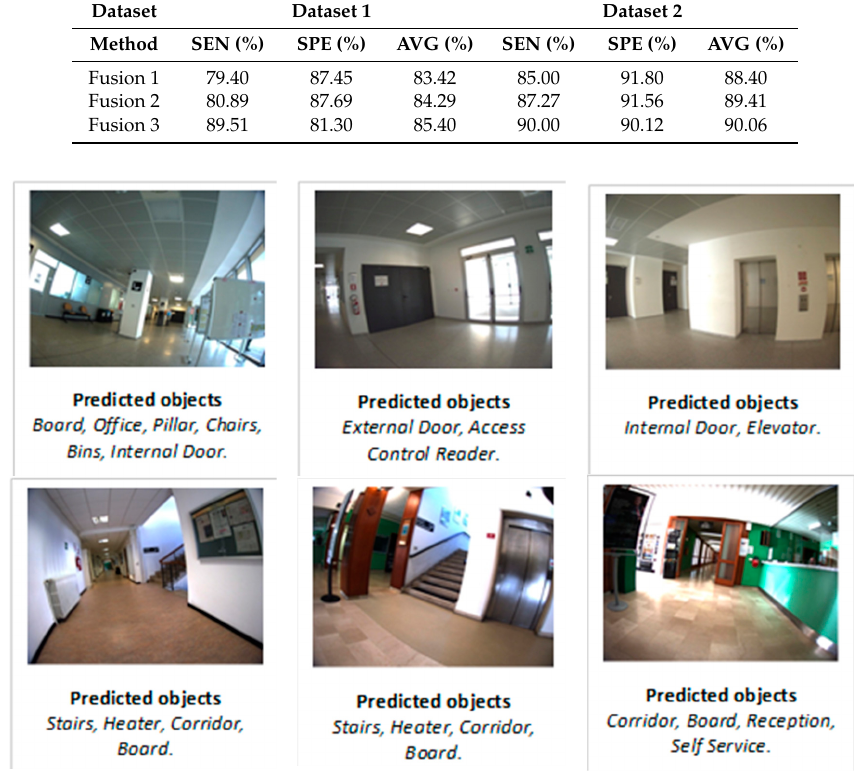
Figure 9. Example of results obtained by the proposed multilabeling fusion approach for both datasets. Upper row for Dataset 1, and lower one for Dataset 2.